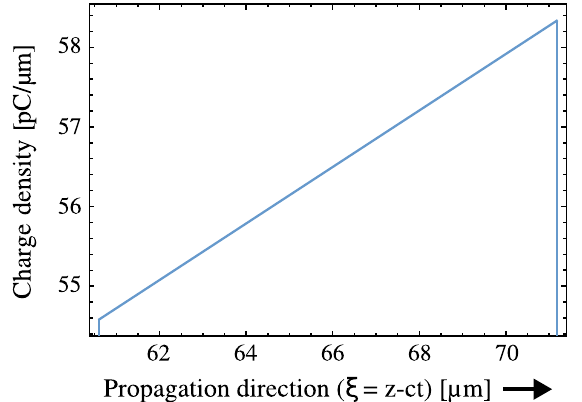
FIG. 4. Plot of the longitudinal trailing beam slice charge density required to beam load the wakefields, Eq. (5), as a function of the injected location in the comoving frame, ξ ¼ z − ct .